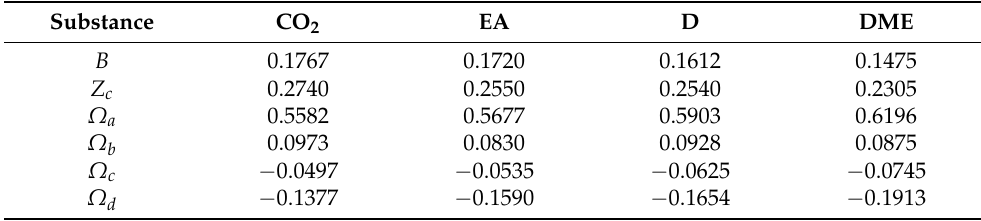
Table 2. The critical compressibility factor ( Z c ), and General Equation of State (GEOS) parameters ( B , Ω a , Ω b , Ω c , Ω d